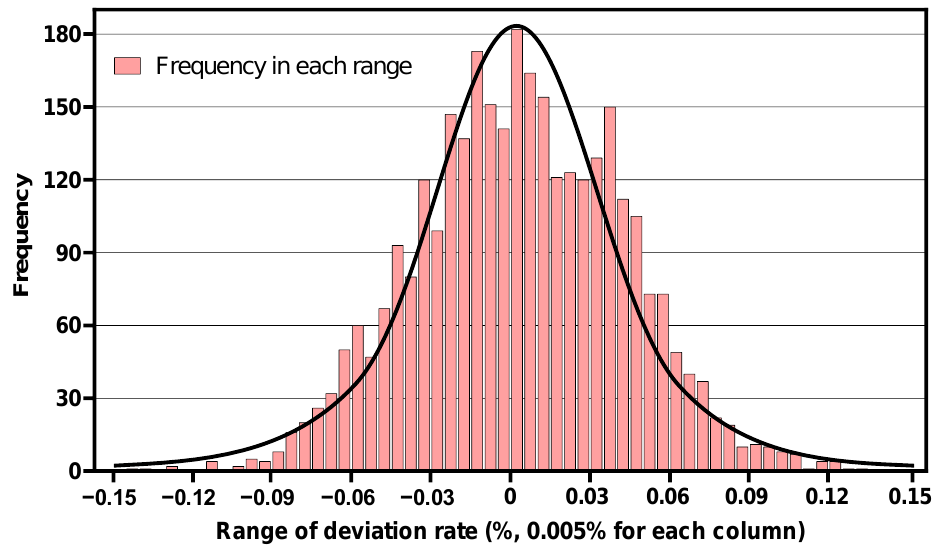
Figure 7. Statistical distribution of deviation rate in sulfur-content calculation of ship fuel oil.